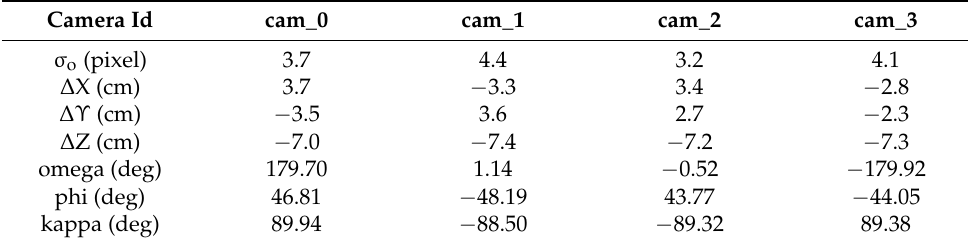
Table 1. Calibration results for all four cameras of a mobile mapping